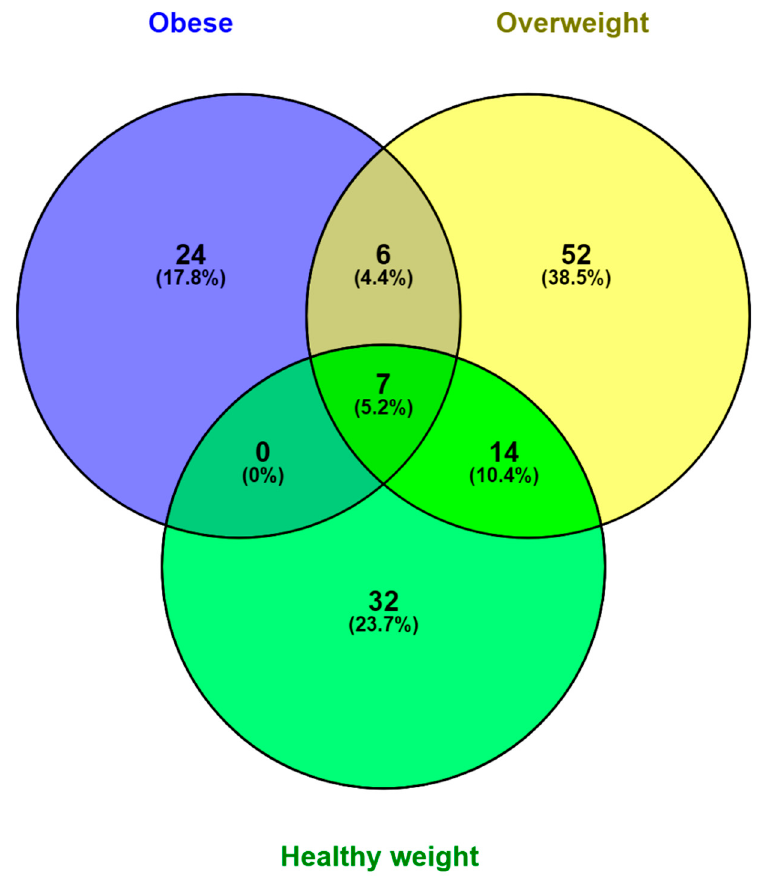
Figure 6. Venn diagram of shared and unique species detected in subgingival samples of subjects grouped based on BMI compared by their periodontal status. The numbers shown represent significantly different species between subjects with no-mild compared to moderate-severe periodontitis .